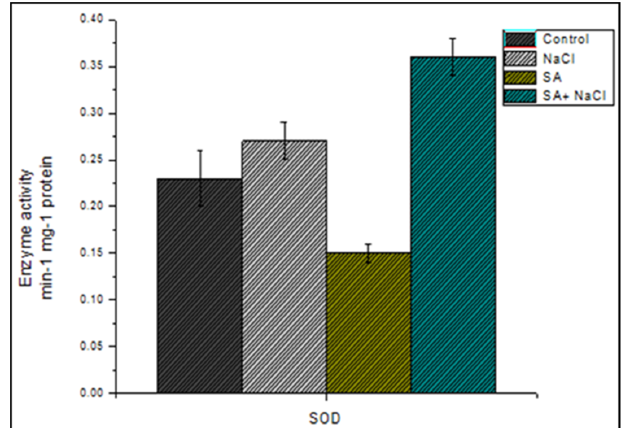
Figure 8. Superoxide dismutase activity: individual and combined effect of salinity and SA on leaf superoxide dismutase. X axis -treatment group; Y axis - enzyme activity (min -1 mg -1 protein) Values are expressed as mean ± SD, n=3 in each group.